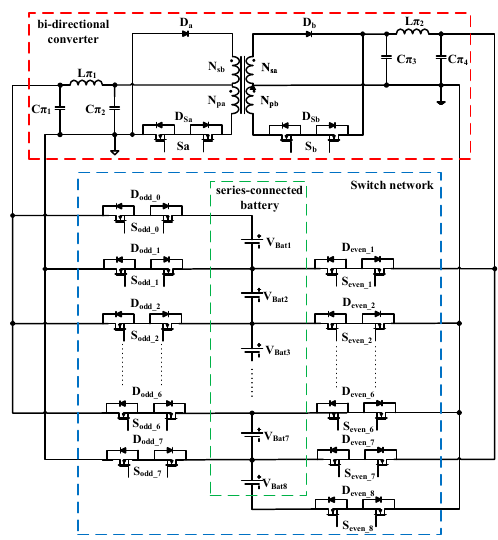
Figure 1. The proposed fast charging balancing circuit for LiFePO 4 battery.